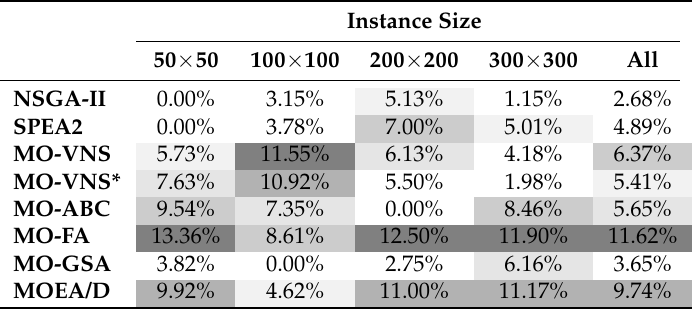
Table 7. Based on hypervolume, percentage of average test cases where a metaheuristic is significant better than any other solving the three-objective